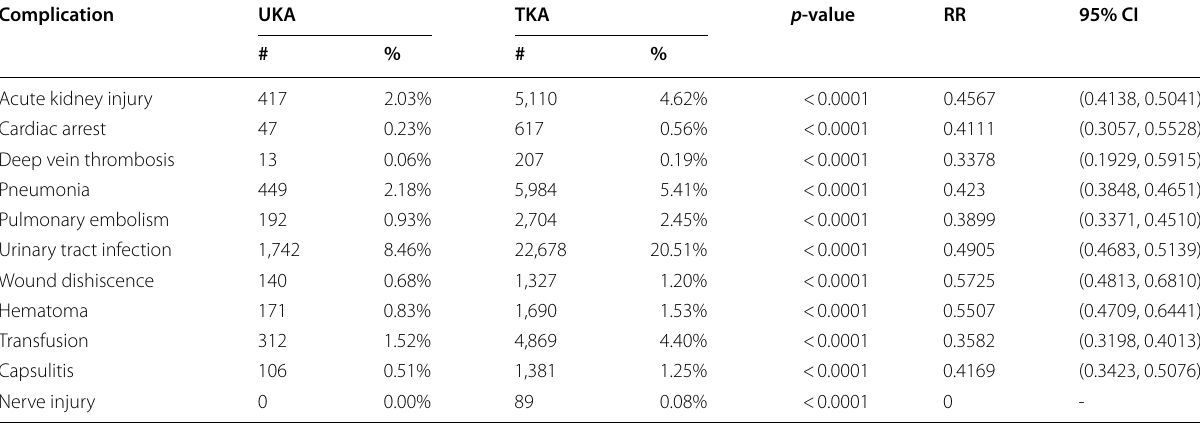
Table 13 Incidence of complications within 12 months following TKA and